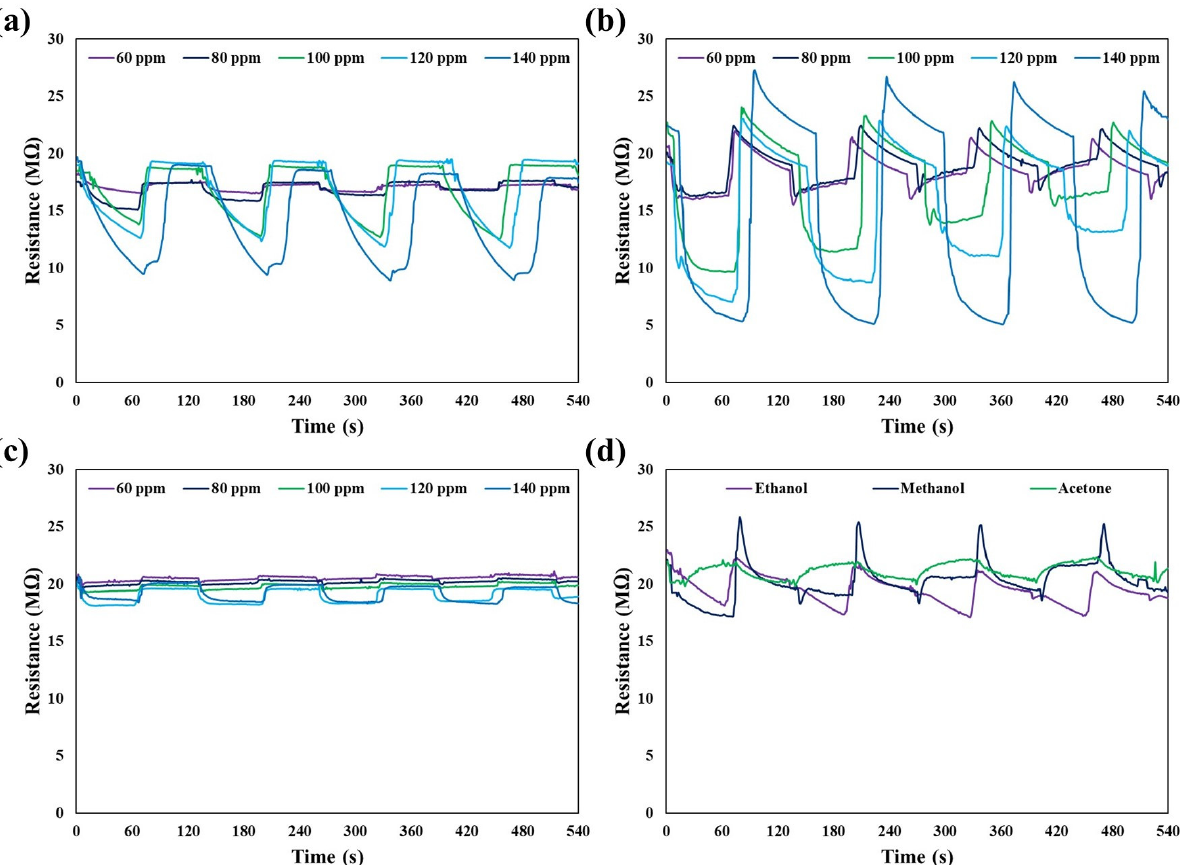
Figure 9. Responses of CNN and CNN/Au to gas upon exposure in four cycles from 60 ppm to 140 ppm of ( a ) ethanol, ( b ) methanol, ( c ) acetone, and ( d ) CNN in four cycles 140 ppm of ethanol, methanol, and acetone at 20 °C.